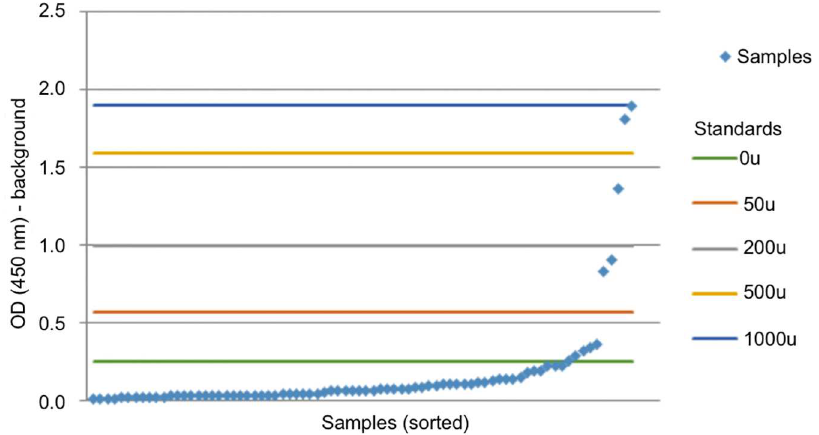
Fig 1. Typical results from an ELISA plate. Specimens are sorted by increasing OD values and are each represented by a separatediamond. The mean values of the controls tested in triplicate are representedby coloured